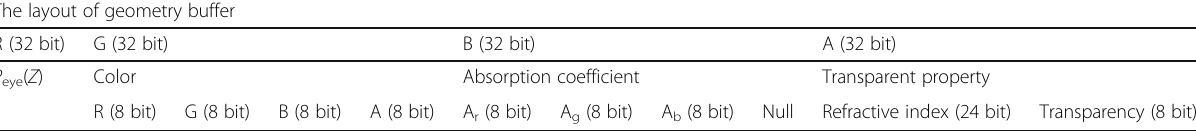
Table 2 The mode of buffer allocation The layout of geometry buffer